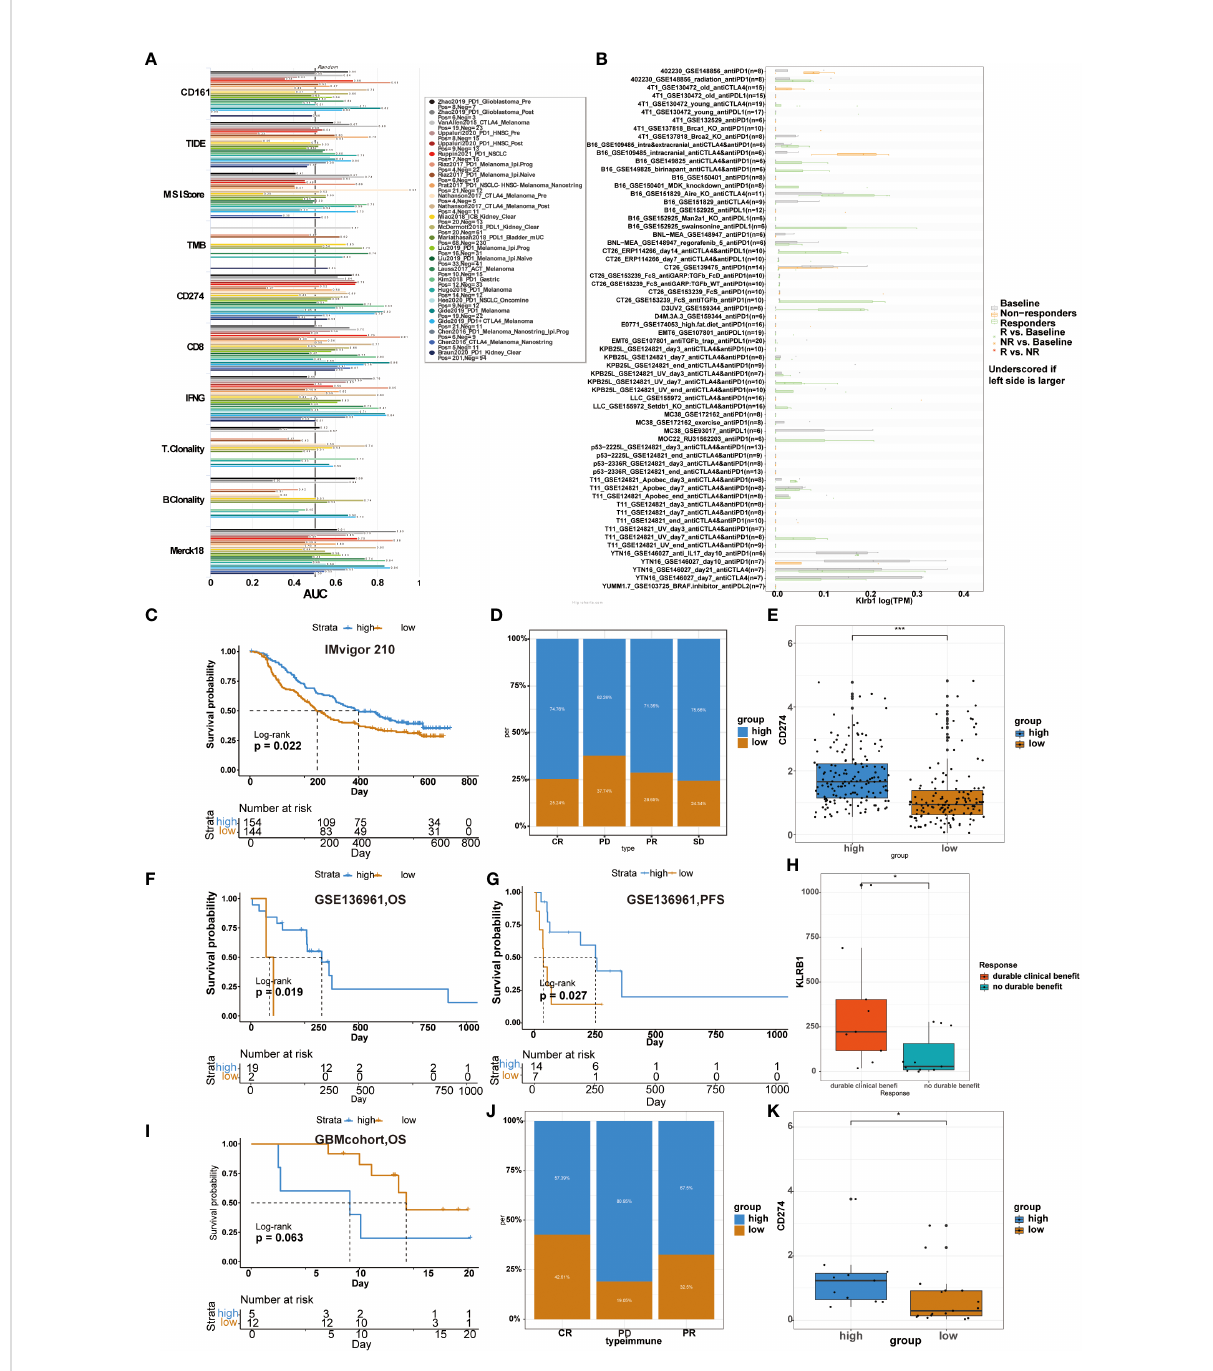
FIGURE 9 Relationship between CD161 expression and immunotherapy from two websites and four databases. Several markers area under the ROC curve (AUC) for predicting immune response (A) . Different ICB treatments stimulated KLRB1 gene expression in various models (B) . In the Imvigor 210 cohort, the correlation between patient risk score and OS (C) . CD161 expression correlated with the treatment intensity and response to PD-L1 immunotherapy (D) . Correlation between patient risk score and CD274 level (E) . The GSE136961 cohort shows the correlation between patient risk score and OS (F) and PFS (G) . Relationship between KLRB1 expression level and clinical bene fi t (H) . In GBM cohort, the correlation between patient risk score and OS (I) . In the GSE78220 cohort, CD161 expression correlated with the treatment intensity and response to PD-L1 immunotherapy (J) . Relationship between patient risk score and CD274 level (K) . *P < 0.05; ***P <